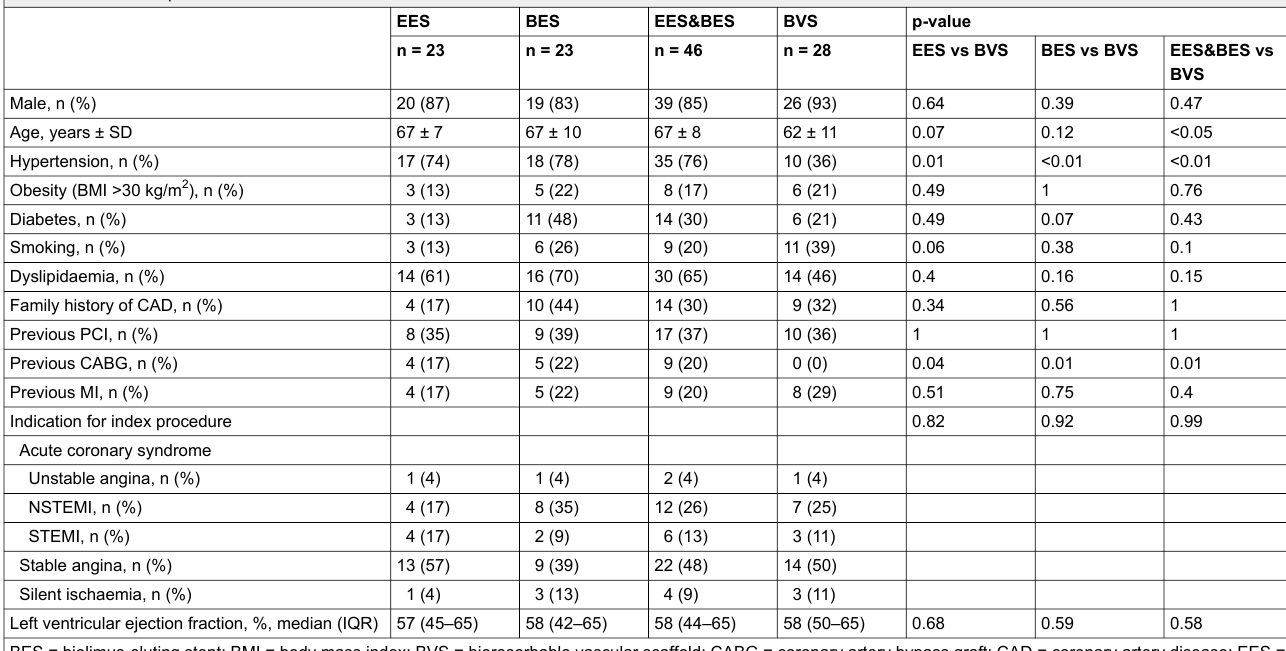
Table S1b: Baseline patient characteristics.